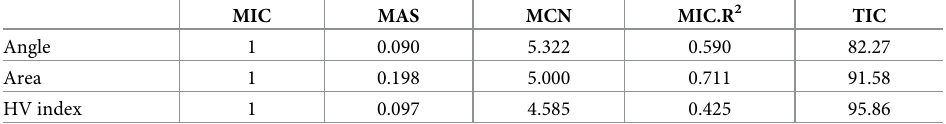
Table 2. The linearity, monotonicity, complexity, and strength of the relationship between the pressure gradient and three different measuring methods. MIC MAS MCN MIC.R 2 TIC Angle 1 0.090 5.322 0.590 82.27 Area 1 0.198 5.000 0.711 91.58 HV index 1 0.097 4.585 0.425 95.86 The maximum information coefficient (MIC), the maximum asymmetry score (MAS), the minimum cell number (MCN), MIC-R 2 , and the total information coefficient (TIC) of IVC–HV junction angle (Angle), least estimated area of iTEV (Area), and HV index are